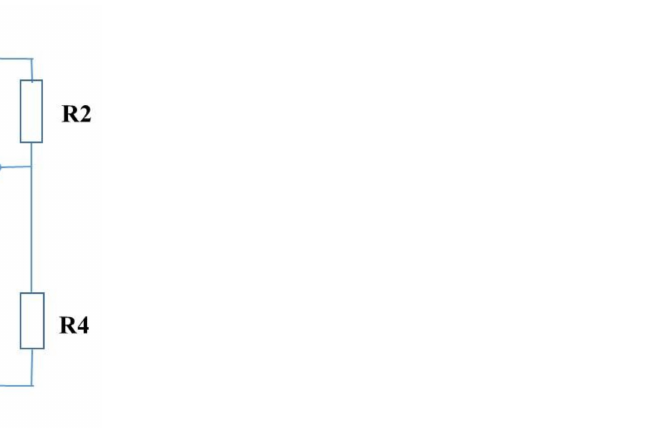
Figure 7. Wheatstone bridge-based circuit for the measurement of the IR and UV lights intensities by use of the Al/OD-Gel/Cu electrochemical Cell (E and